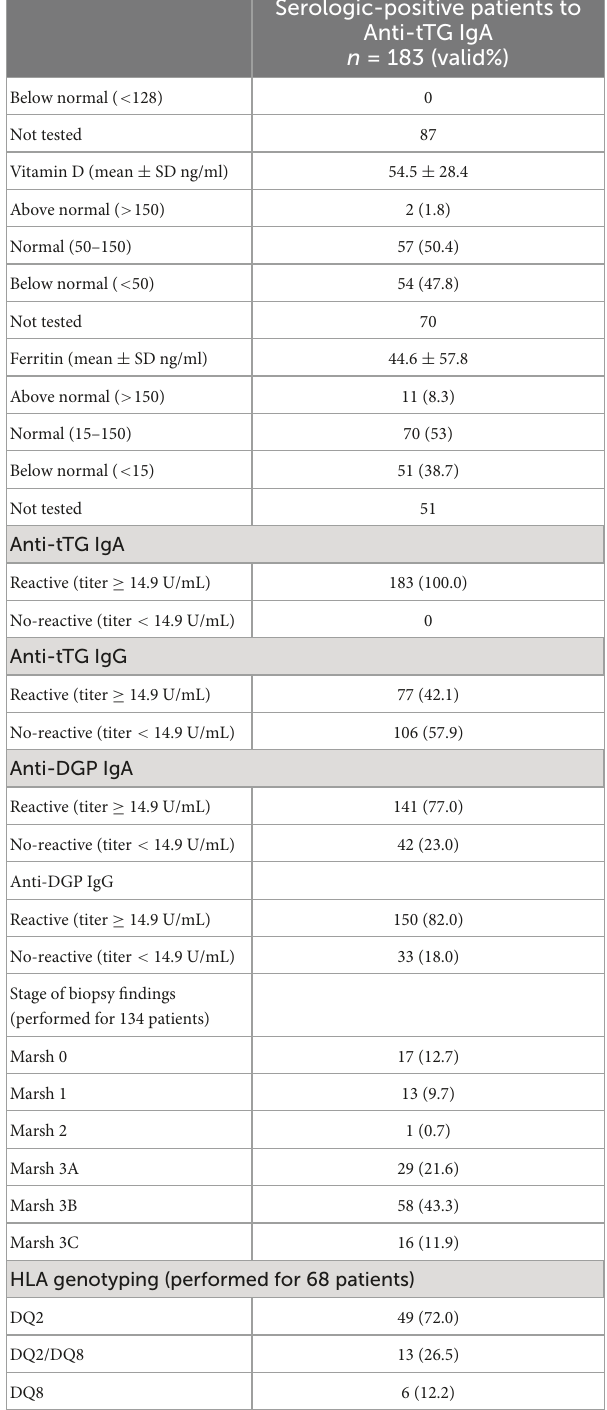
TABLE 1 Socio-demographic characteristics, co-morbidities, and laboratory findings of the included 183 CD patients who are serologically confirmed using the Anti-tTG IgA